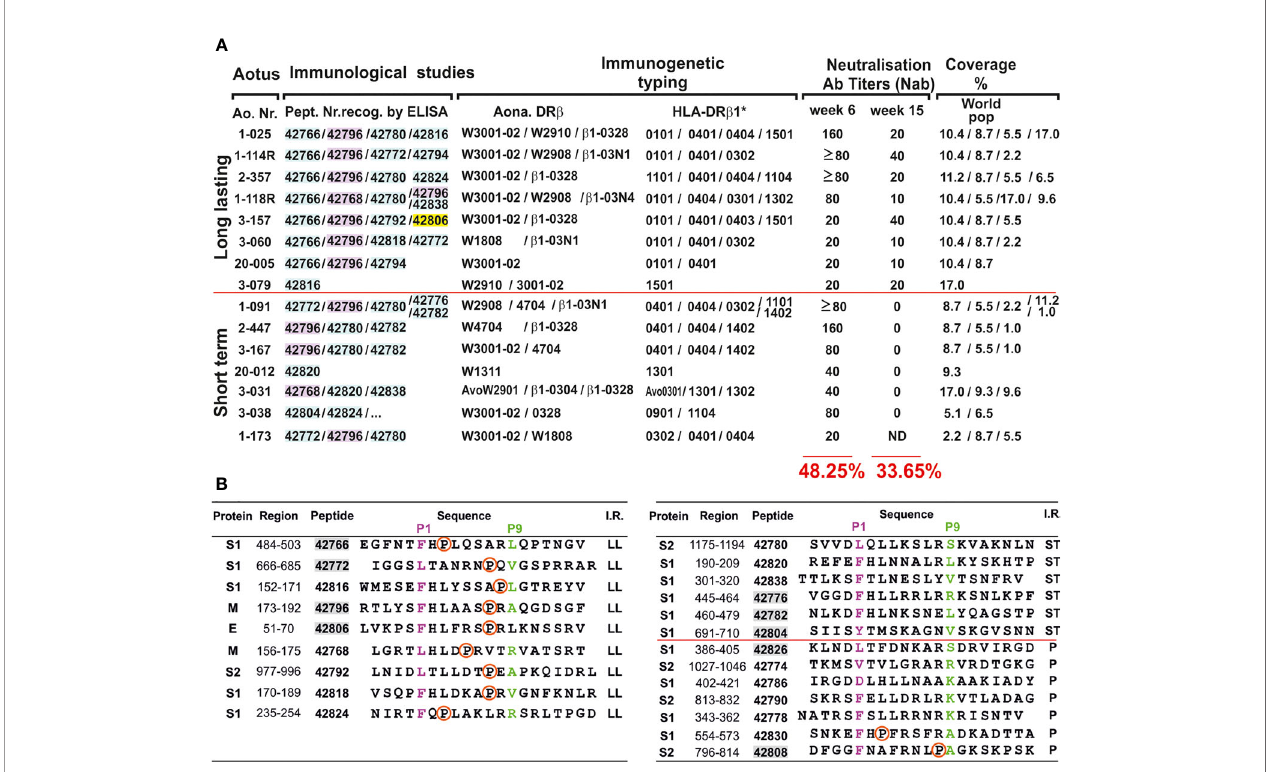
FIGURE 4 | Correlation between immunological studies, immunogenetic typing, NAbI titres, world population coverage and COLSARSPROT peptide sequence. (A) Potential COLSARSPROT peptide-induced coverage % (bold numbers at the bottom and in red 6 and 15 weeks pi immunisation) based on LiViNAb reactivity associated with Aona-DR b and HLA-DR genotyping and HLA-DR b 1* allele frequency (coverage); highlighted peptide numbers: S-derived (pale blue), M-derived (pink), E-derived (yellow). (B) Proline location in all (9/9) modi fi ed LL-LiViNAbI (red circle); absent in all (6/6) ST-LiViNAbI and present in just 2/7 promiscuous ones. Shadowed numbers in grey: modi fi ed peptides analysed by 1